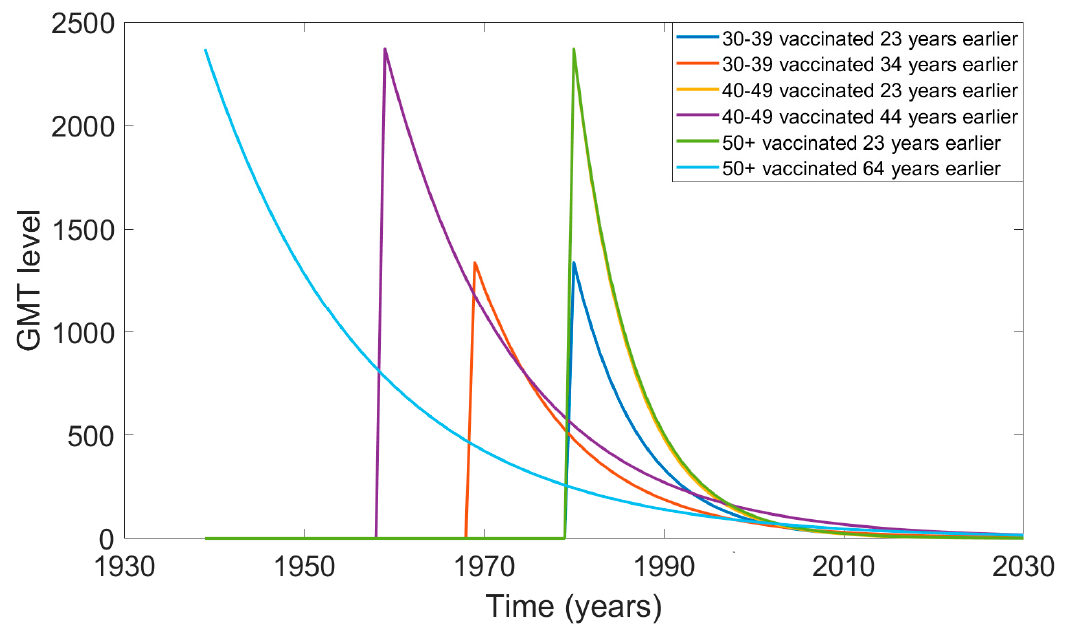
Figure 3. Projected decline in GMT level over time for the two scenarios for time since last vaccination in each age group.